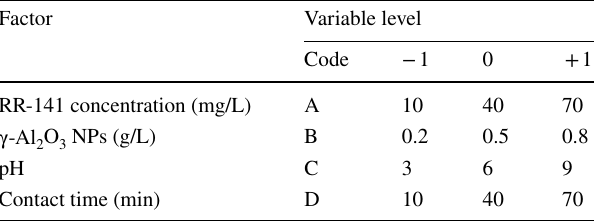
Table 1 Range and levels of main parameters used for the RR-141 adsorption